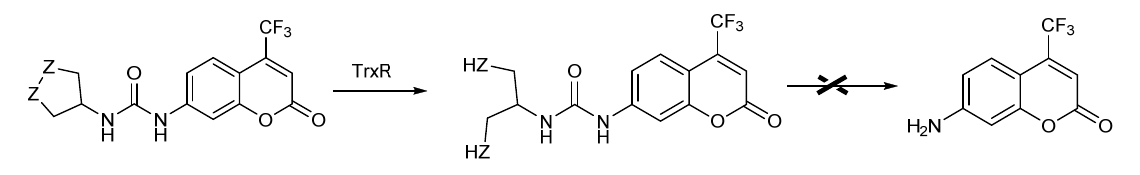
Figure 26. One–step activation of Fast–TRFS reported by Li et al.